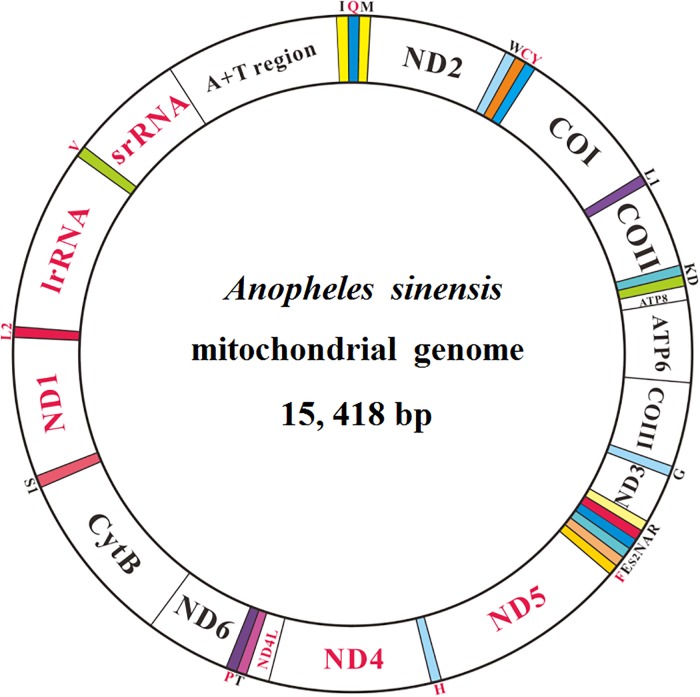
Structure of the Anopheles sinensis mt genome.The color-filled blocks indicate tRNAs, and the unfilled white blocks denote protein-coding genes (PCGs), rRNAs and control region (CR). The tRNAs, PCGs, rRNAs and CR located on the majority strand are marked in black, and those on the minority strand are marked in red.